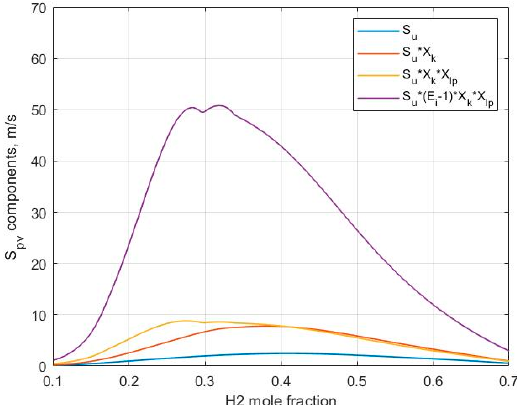
Figure 2. Components of the “piston” velocity, 𝑆 (cid:3043)(cid:3049) (m/s), as a function of hydrogen mole fraction in hydrogen ‐ air mixture— 𝑆 (cid:3048) : laminar burning velocity (m/s); 𝜒 (cid:3012) : Karlovitz’s factor accounting for in hydrogen-air mixture— S u : laminar burning velocity (m/s); χ K : Karlovitz’s factor accounting the turbulence generated by the flame itself ( ‐ ); 𝜒 (cid:3039)(cid:3043) : factor accounting for the preferential diffusion phenomenon in turbulent flames ( ‐ ); 𝐸 (cid:3036) : combustion products expansion coefficient ( ‐ ).